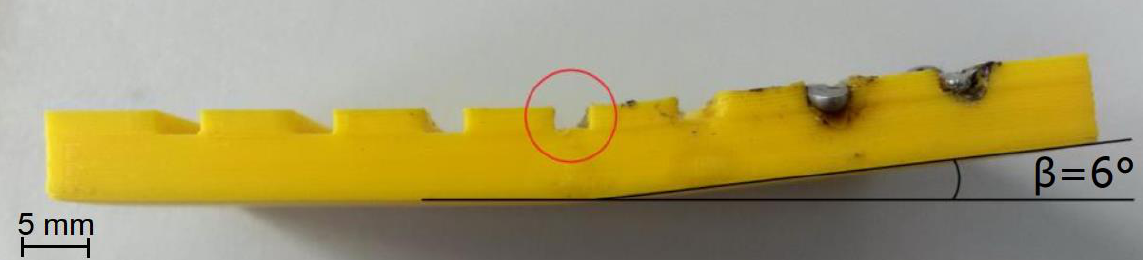
Figure 5. Deformation of the substrate as a result of thermal shock from applied liquid solder alloy 7 times in the same groove (red circle). times in the same groove (red